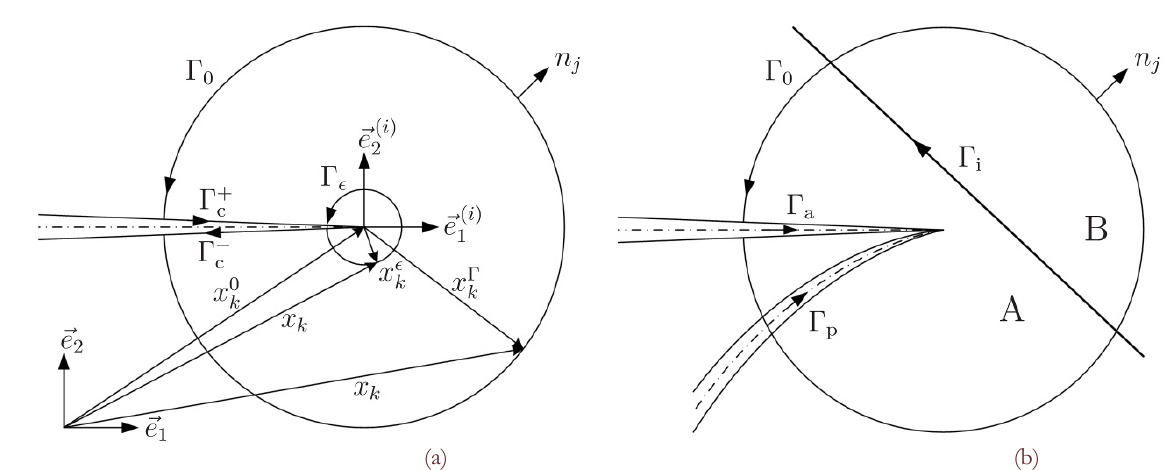
 ) crack  ) and auxiliary ( a p